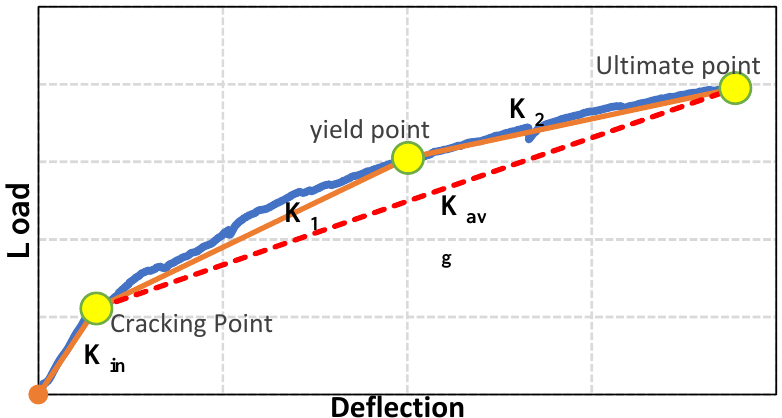
Figure 10. Initial and average stiffness for tested specimens. Table 5. Stiffness for tested